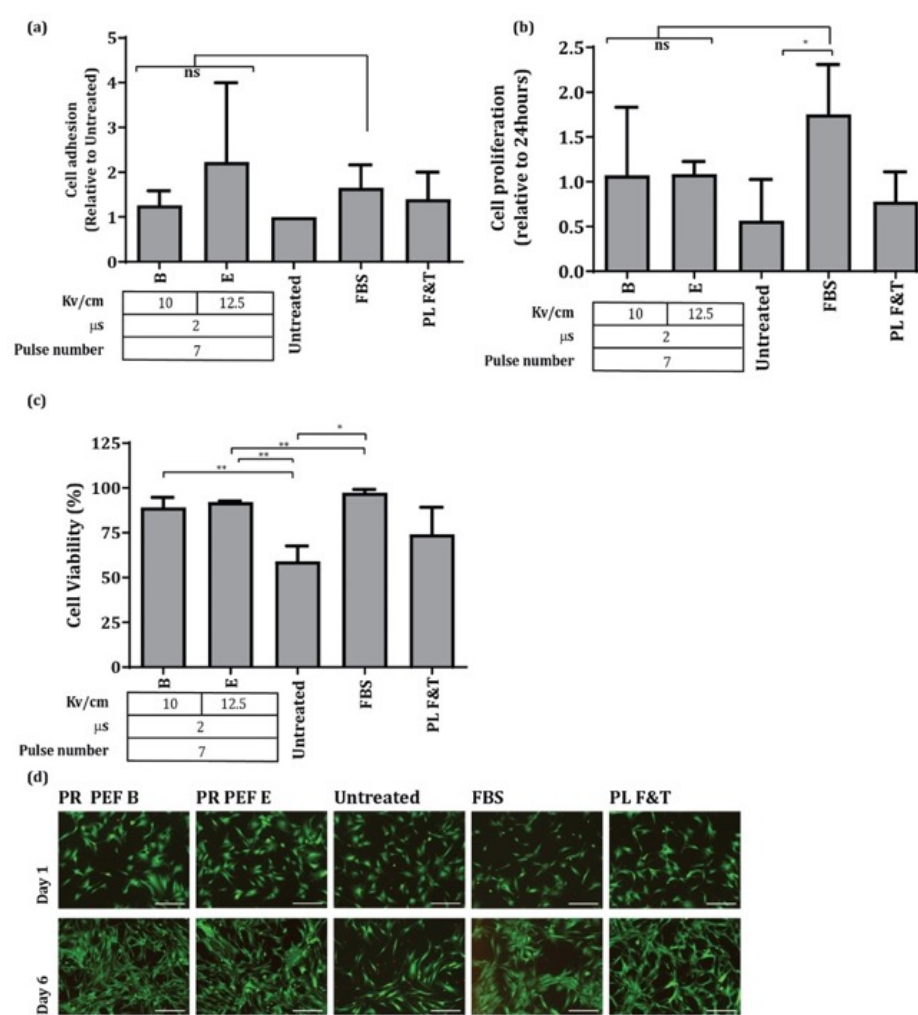
Figure 3. BM-MSC expansion in media supplemented with PR obtained upon PEF treatment, PL F&T, and FBS. ( a ) BM-MSC adhesion one day after cell seeding in media supplemented with PR PEF, untreated PR, or FBS. Results plotted relative to the untreated condition. ( b ) BM-MSC proliferation of cells cultured in media containing PR obtained by the application of PEF B, E and H, PL F&T, and FBS. ( c ) MSC viability after 6 days in culture in the presence of PR, PL F&T, and FBS. ( d ) Live (FDA) and dead (Pi) staining of MSCs for 1 and 6 days in culture with PR. Mean ± SD is shown. n = 3. ns = non-significant. * p < 0.05, ** p < 0.01.